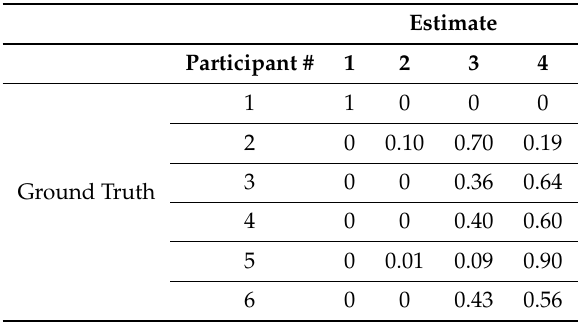
Table 14. Confusion matrix for identification based on an Euclidean distance minimization approach applied to RSS data from both the 433 MHz and 868 MHz network.